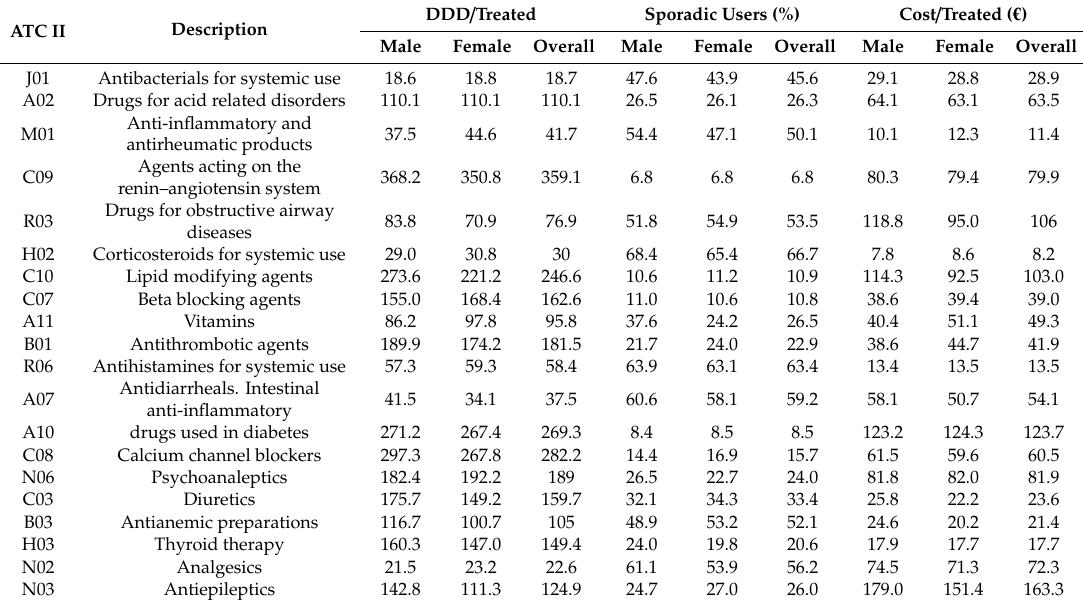
Table 3. Gender di ff erence in DDD / treated, sporadic users (%) and cost for treated of drug therapy (ATC